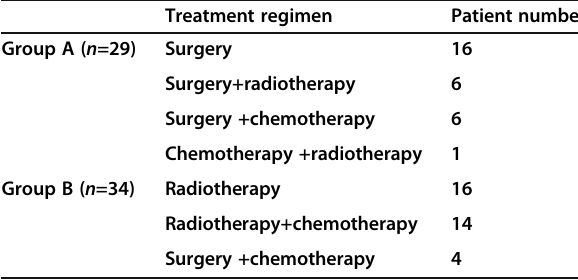
Table 1 Treatment regimen of groups A and B patients Treatment